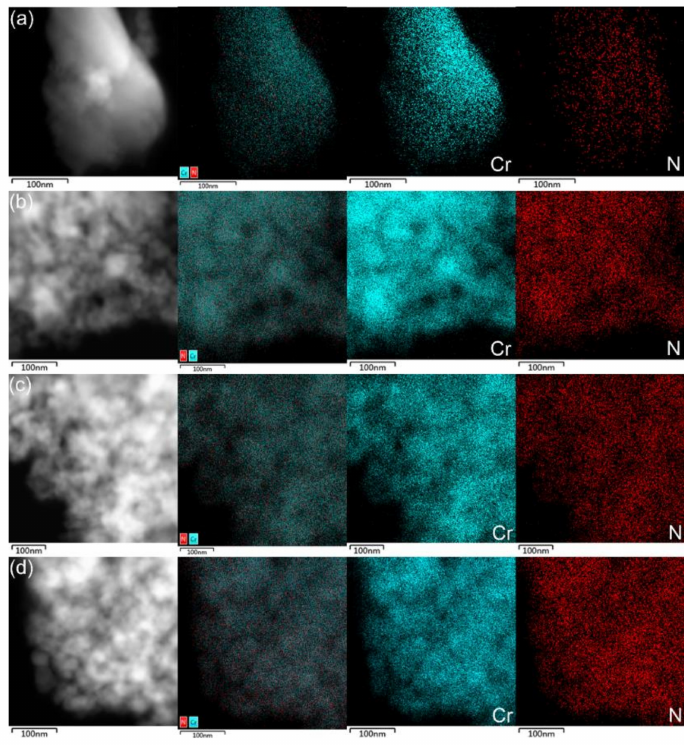
Figure 6. EDX elemental mapping measurements of the derived samples: ( a ) T 26 thin film, ( b ) T 44 thin film, ( c ) T 82 thin film, ( d ) T 130 thin film.